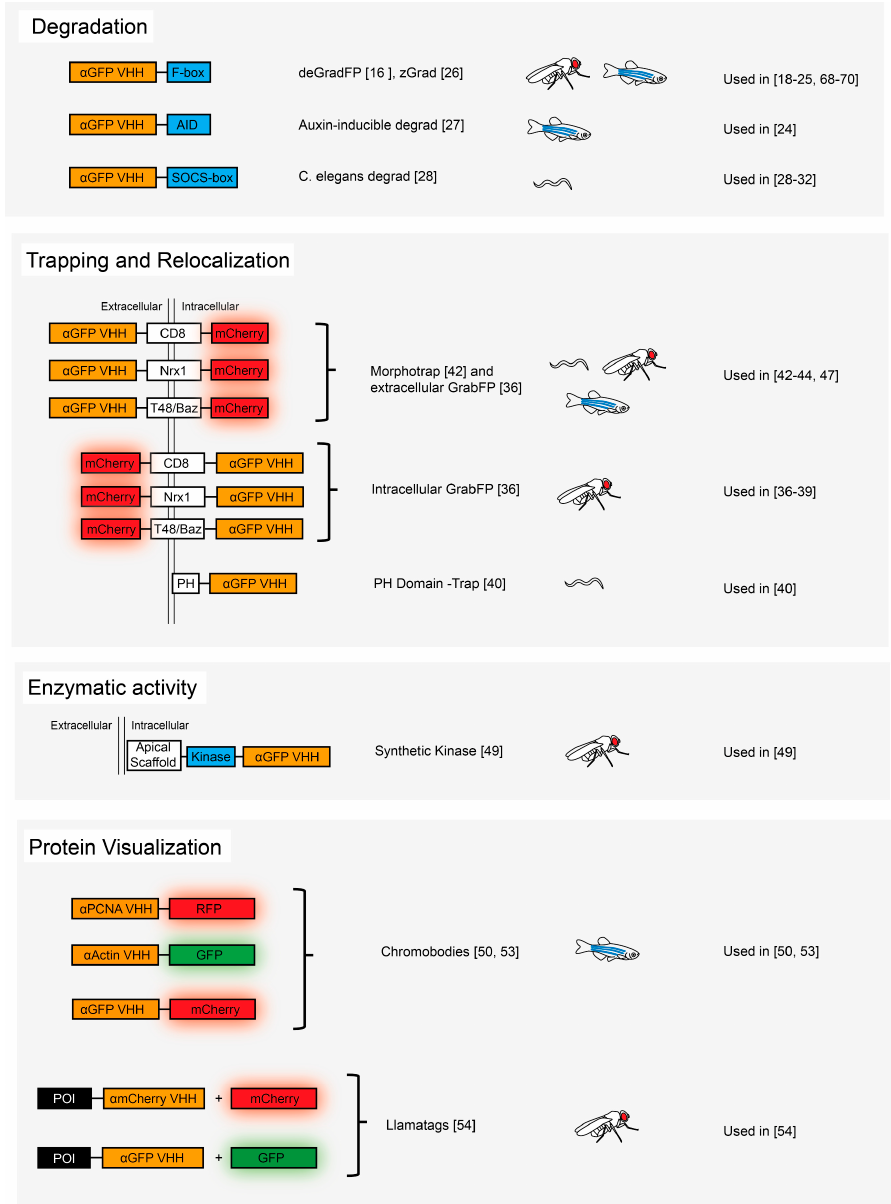
Figure 1. Different nanobody-based methods applied to developmental biology.